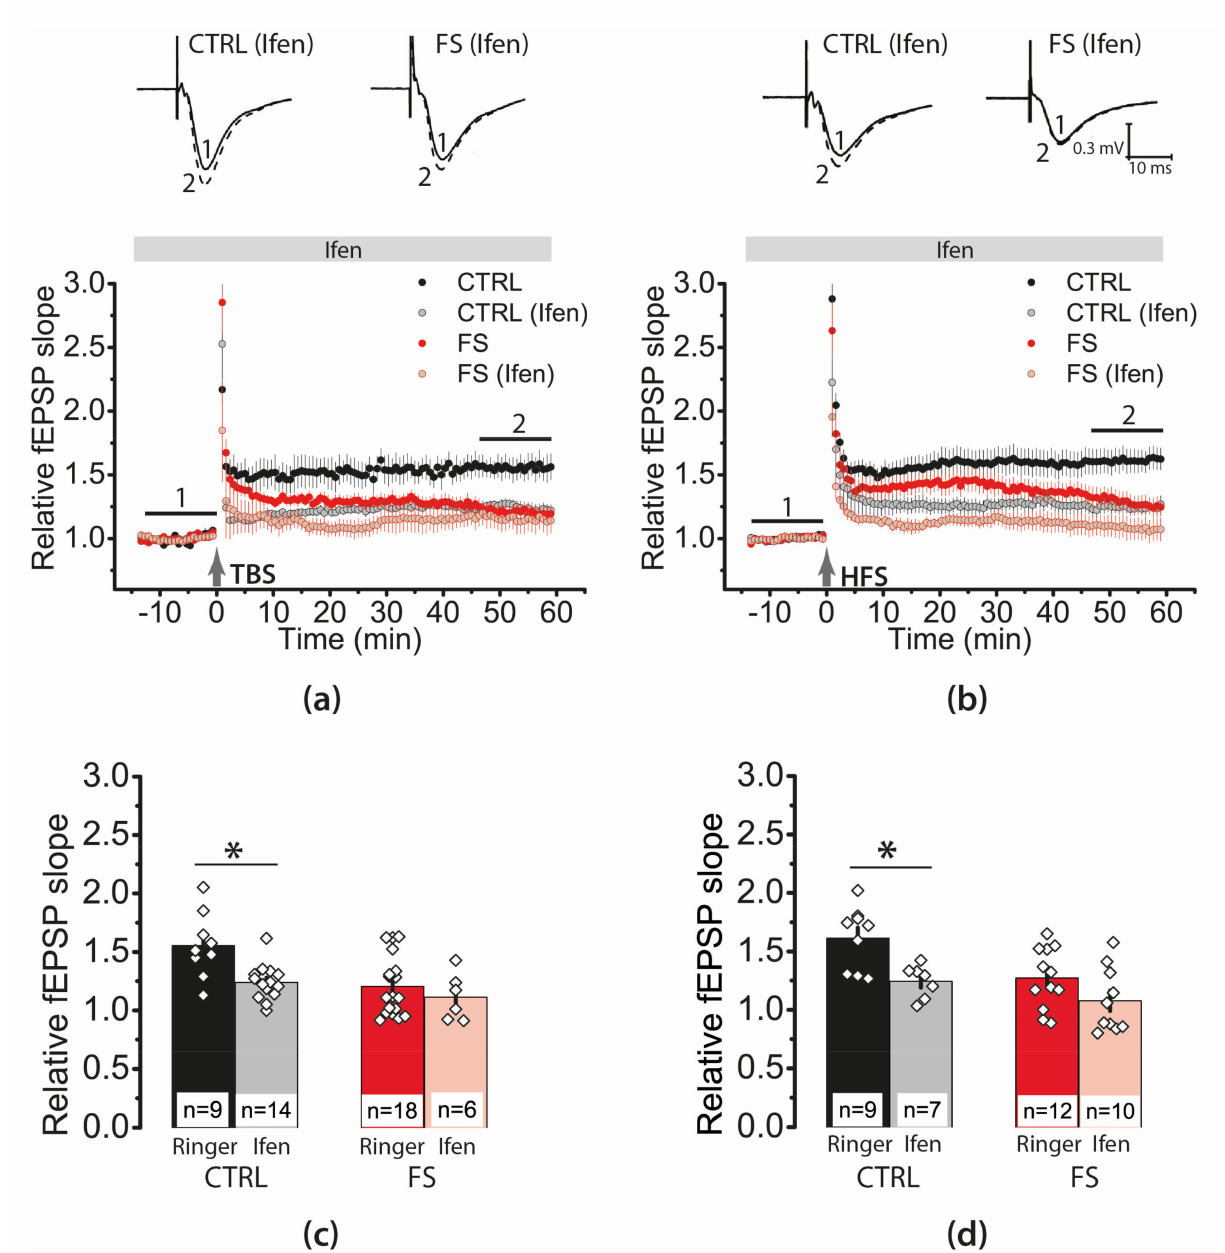
Figure 6. GluN2B-containing NMDARs were involved in the induction of LTP in both control and post-FS animals. The relative fEPSP slope in the control and experimental groups in the presence of ifenprodil (Ifen, 3 µ M), a selective GluN2B- containing NMDAR antagonist, before and after TBS ( a ) or HFS ( b ). Note that no synaptic plasticity was detected in the presence of ifenprodil in FS groups. ( c , d ) Diagrams illustrating the magnitude of plasticity in the control and post-FS groups in the presence of ifenprodil, after TBS ( c ) or HFS ( d ). Note that no synaptic plasticity was detected in the presence